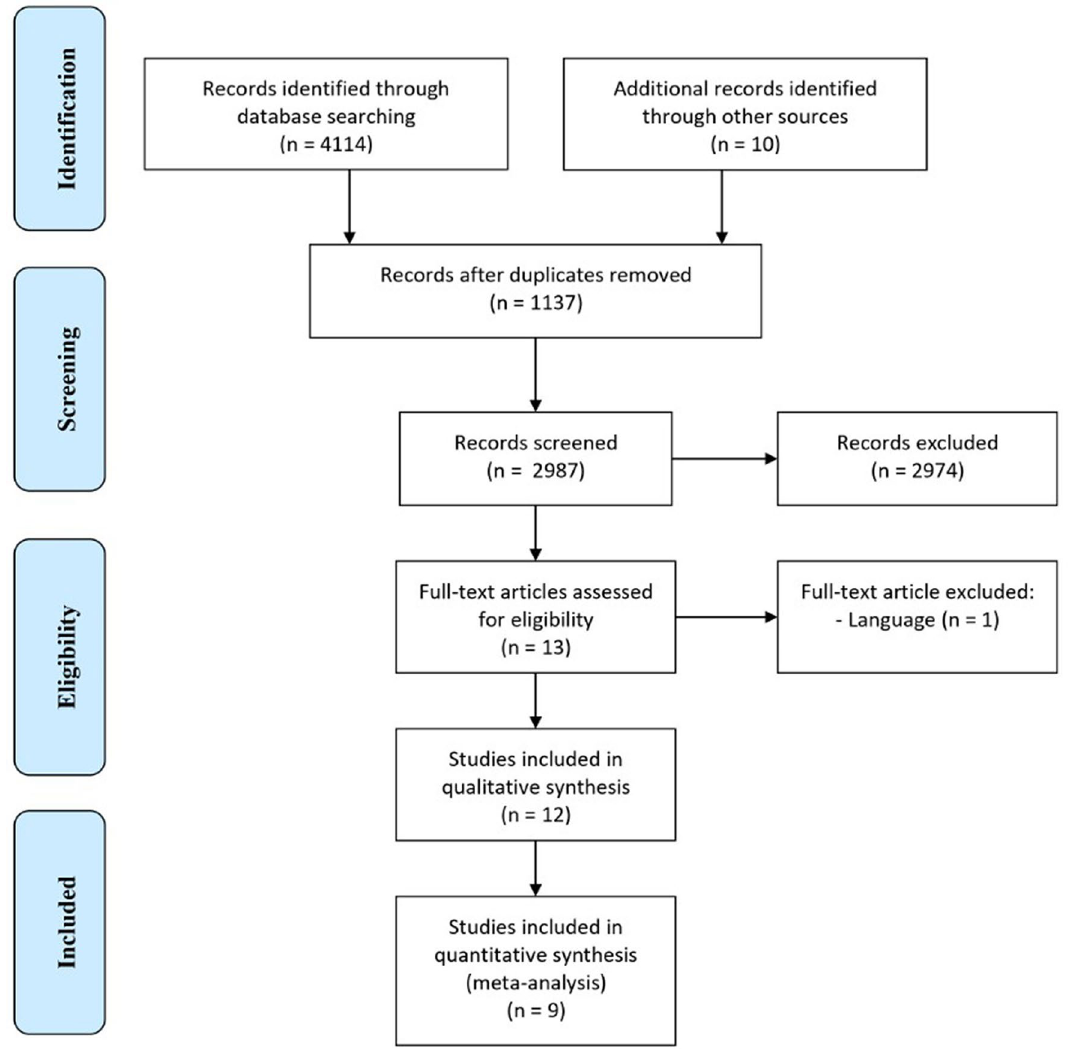
Figure 1. Preferred reporting items for systematic reviews and meta-analyses flow